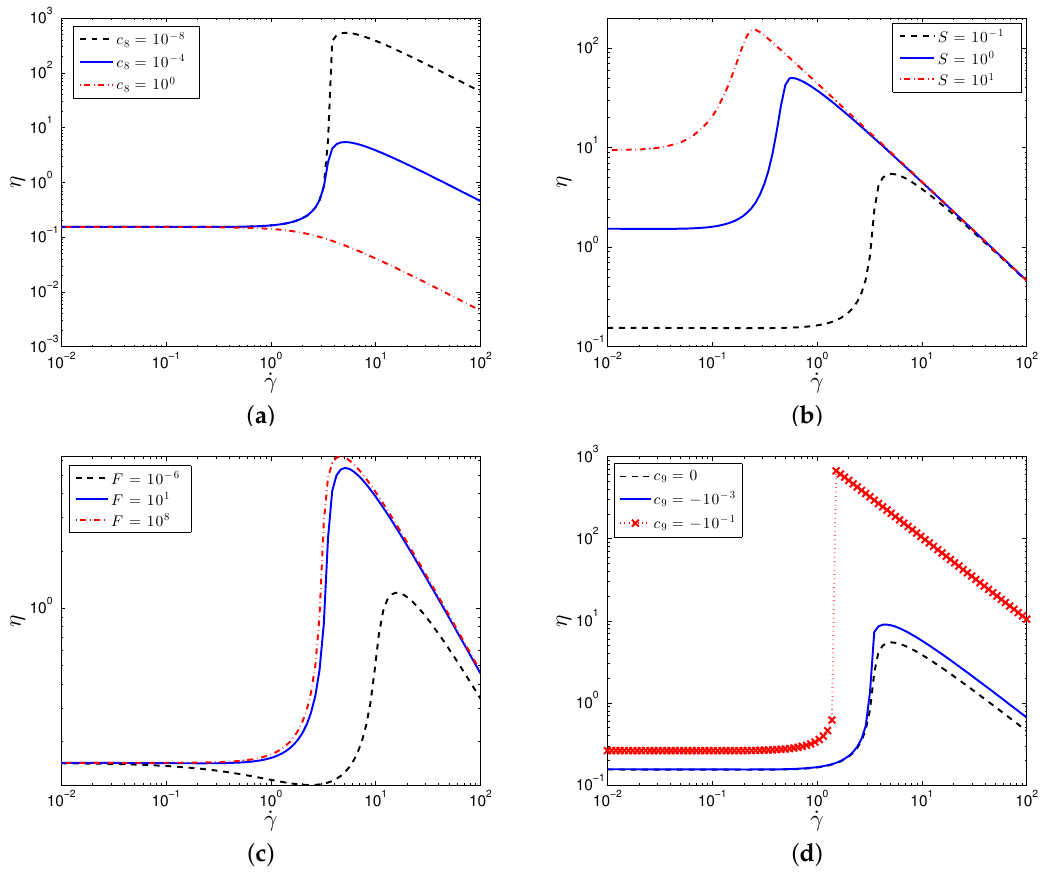
Figure 2. Plot of the particle contribution to the viscosity, η = Π xy / ˙ γ , against shear rate for varying values of ( a ) c 8 , ( b ) S , ( c ) F , and ( d ) c 9 . Parameter values are: S = 10 − 1 , F = 10, c 3 = − 23.5, c 7 = − 0.47, c 8 = 10 − 4 , c 9 = 0, η S = 1, f ( φ ) = 1.0957, k 1 = − 10 3 , k 4 = −